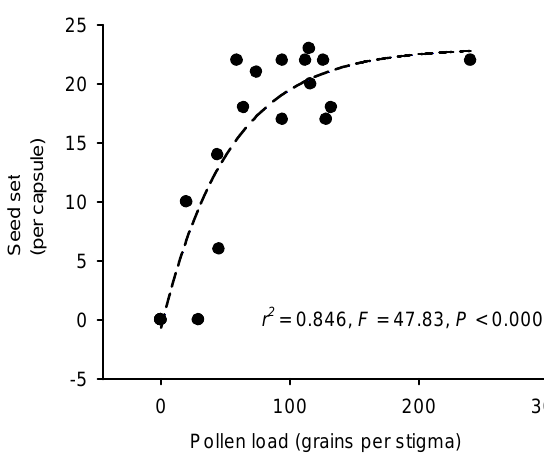
F IGURE 4. Effect of Ptilothrix bombiformis pollination efficiency on H. moscheutos incanus seed set in the 2014 study. Line shows a strong curvilinear response of host reproductive output to stigmatic pollen loading by visiting P. bombiformis